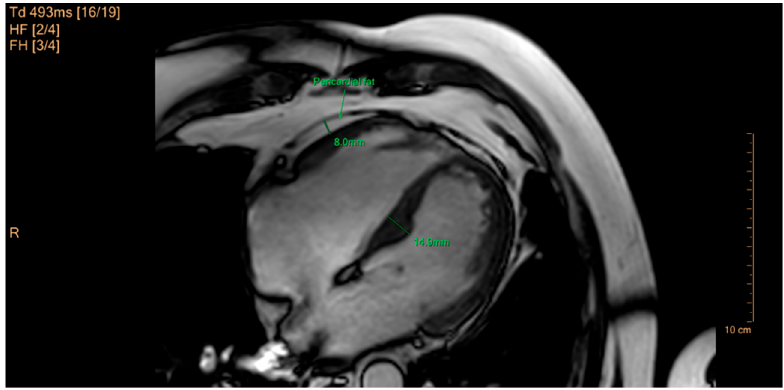
Figure 10. Cardiac MRI , BTFE sequence, cine four chamber view, 8 mm, telediastolic measurement of interventricular septum exhibiting hypertrophy (14.9 mm), epicardial fat thickness of 8 mm lat- eral of the right ventricle. Prepared by the authors. Courtesy of the Pediatric Clinical Hospital Sibiu, Lucian Blaga University of Sibiu.